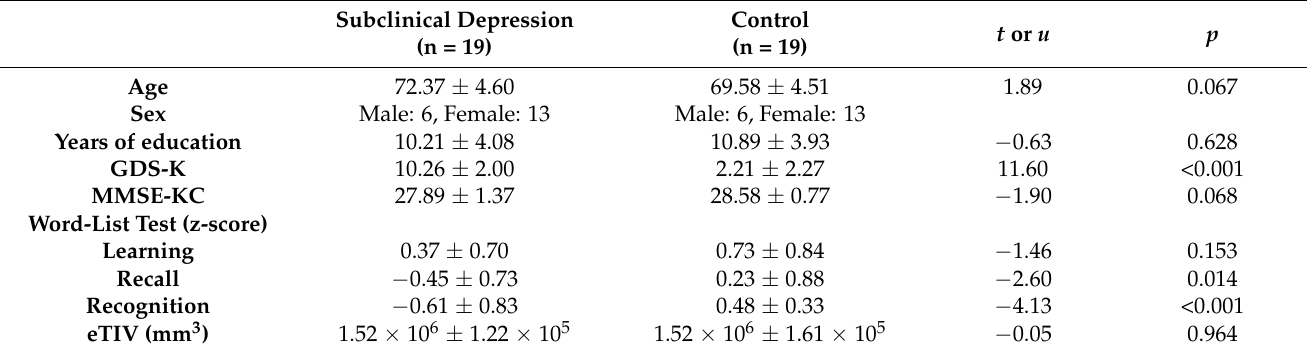
Table 1. Demographic characteristics and memory scores in each group (mean ±